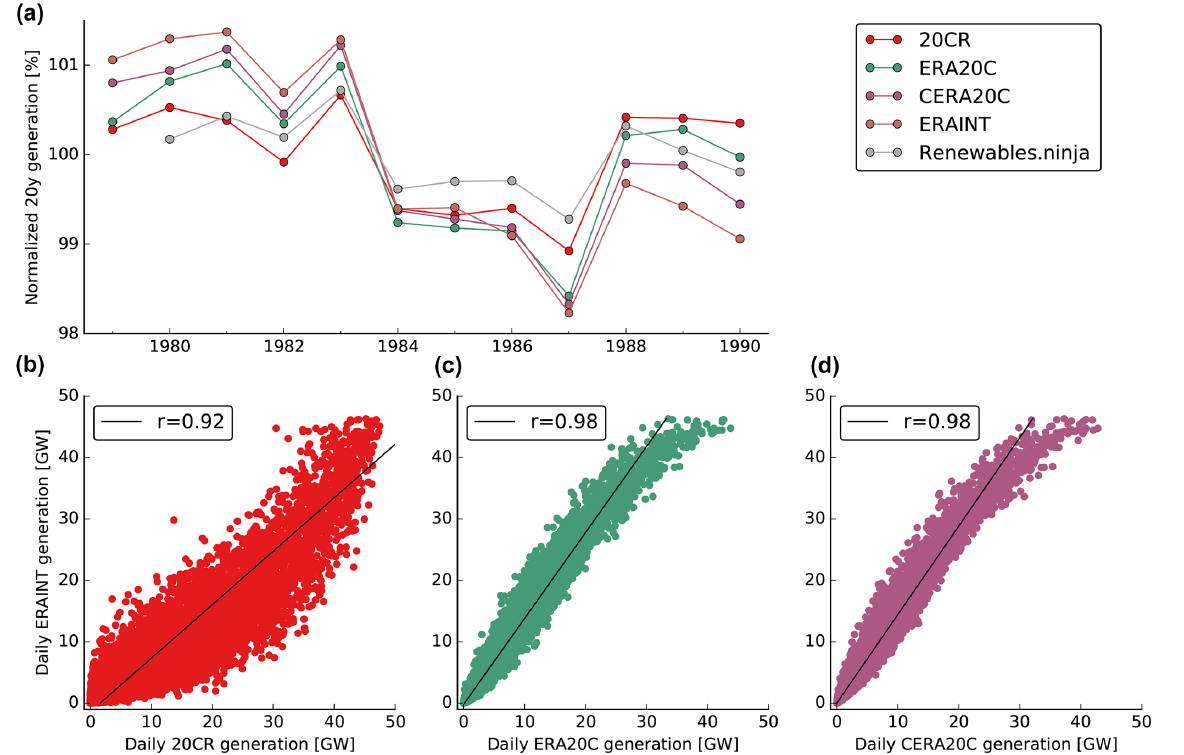
Figure 2. German wind power generation from modern reanalyses (ERAINT, MERRA2) and 20th century reanalyses (20CR, ERA20C, CERA20C) for period of overlap. (a) Normalized lifetime generation (i.e., the reported value for 1990 is the average wind power generation of the years 1990–2009 normalized with the long-term mean). “Renewables.ninja” is an openly available generation dataset that is based on MERRA2. (b–d) Scatter plots of daily generation from ERAINT versus daily values from 20CR (b) , ERA20C (c) and CERA20C (d) for the 30-year period from 1979 to 2009. The Pearson correlation coefficient, r , between the daily data is given in the legends. The data are shown prior to long-term trend removal, which was performed for the centennial analysis (see Sect.